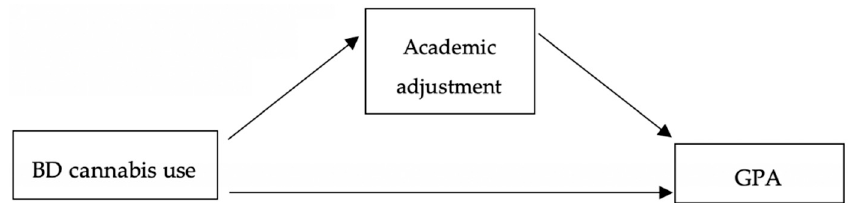
Figure 1. Mediation model for academic adjustment in the relationship between alcohol/cannabis consumption and grade point average (GPA).